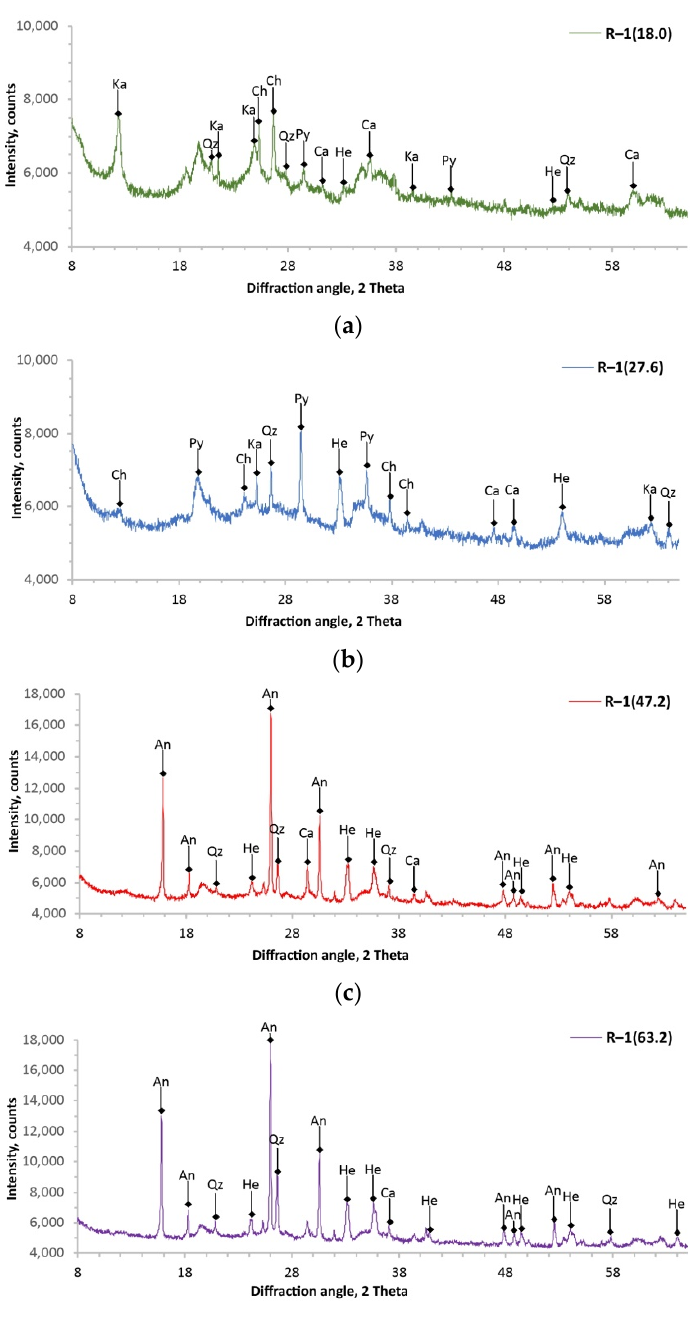
Figure 5. The X-ray patterns of core samples from Radoshivka–1 well: R–1(18.0) ( a ); R–1(27.6) ( b ); R–1(47.2) ( c ); R–1(63.2) ( d ). Ch, chlorite; An, analcime; Qz, quartz; Ka, kaolinite; Py, pyroxene; He, hematite; Ca, calcite.